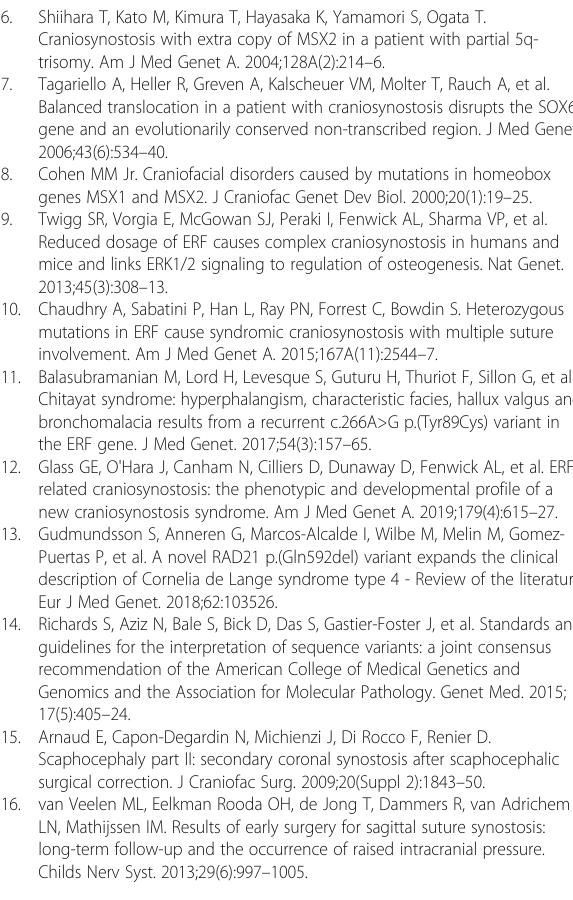
Abbreviations BLSS: Bilateral lambdoid and sagittal synostosis; CS: